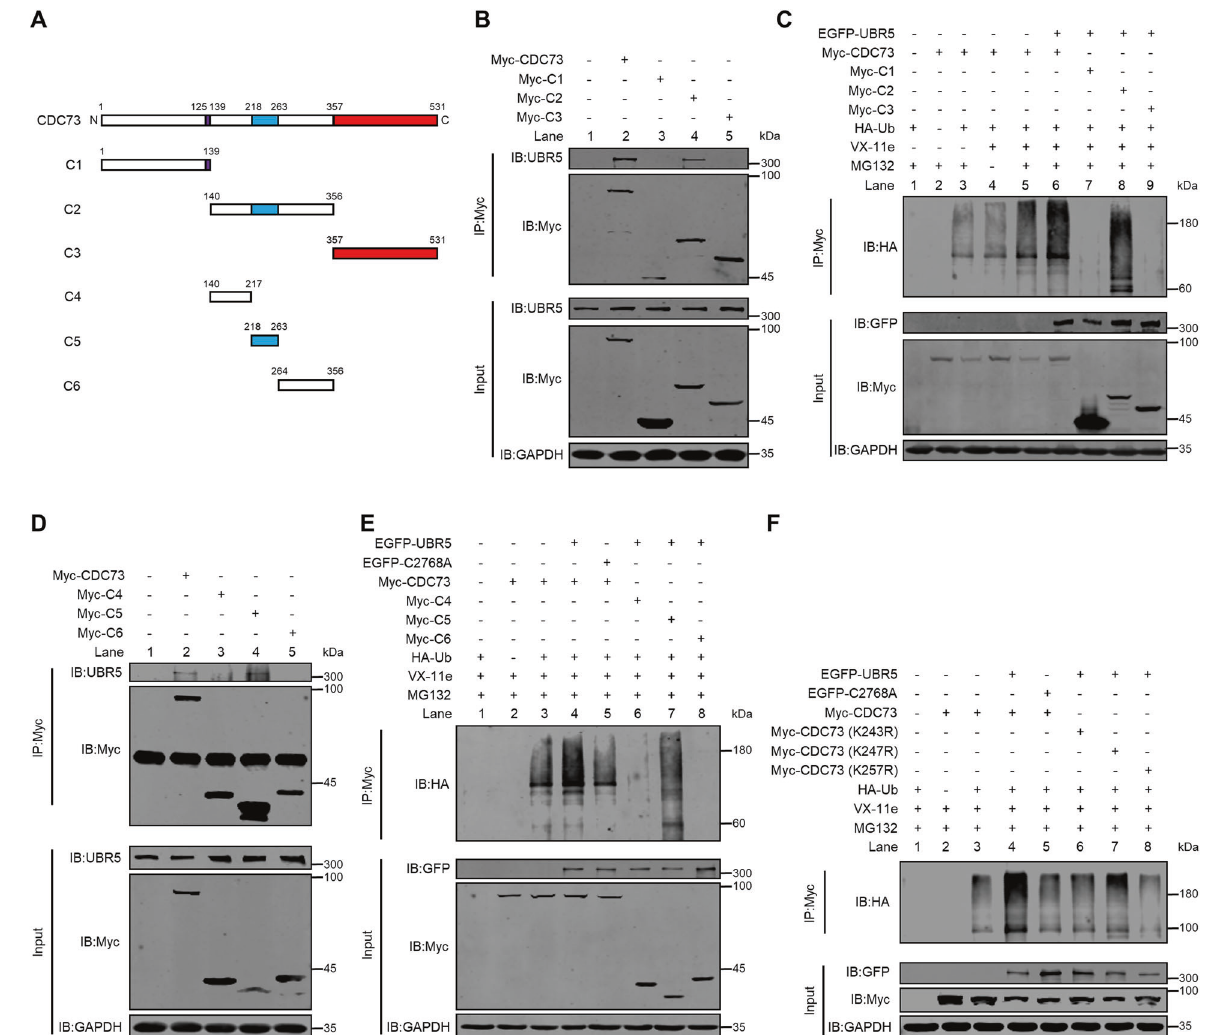
Fig. 7 Identi fi cation of CDC73 ’ s key residues for UBR5-mediated ubiquitination. A The schematic diagram of the full length and truncated fragments of CDC73. Co-IP with anti-Myc antibody analyzed the physical interaction of UBR5 with the full length or truncated fragments of CDC73 C1, C2, and C3 ( B ), and C4, C5, and C6 ( D ) in HEK293T cells transfected with the indicated plasmids in the presence of MG132 (10 μ M, 8 h). Ubiquitination assays analyzed the ubiquitination level of the full length of CDC73 and its truncated fragments C1, C2, and C3 ( C ), and C4, C5, and C6 ( E ) modi fi ed by exogenous UBR5 under denaturing conditions in HEK293T cells transfected with the indicated plasmids and treated with vehicle, VX-11e (10 μ M, 24 h) or/and MG132 (10 μ M, 8 h). F Ubiquitination assays analyzed the ubiquitination level of WT and the mutants of CDC73 (K243A, K247A, and K257A) in HEK293T cells under the same condition as described in ( C ) and ( E